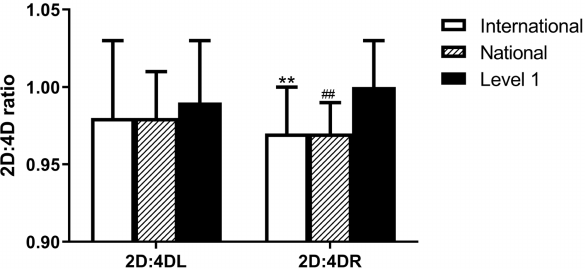
Fig. 1. 2D:4D Difference of elite archers of various levels (** p < 0.05).